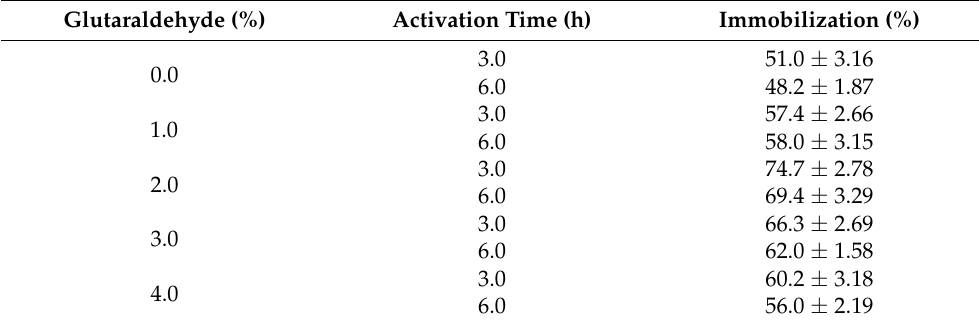
Figure 4. Influence of different chitosan concentrations on Melac13220 immobilization efficiency of chitosan beads. All the results are represented as the means ± standard deviation from at least three independent experiments. Table 2. The optimization of glutaraldehyde concentration and activation time for laccase immobi- lization on chitosan beads.